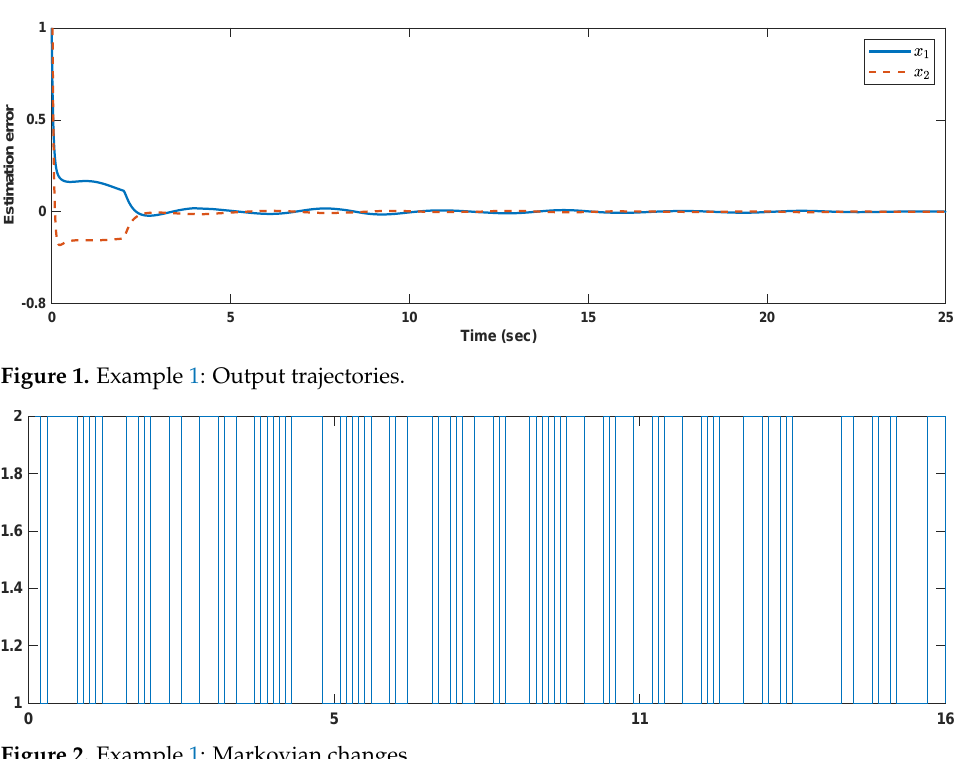
Figure 2. Example 1: Markovian